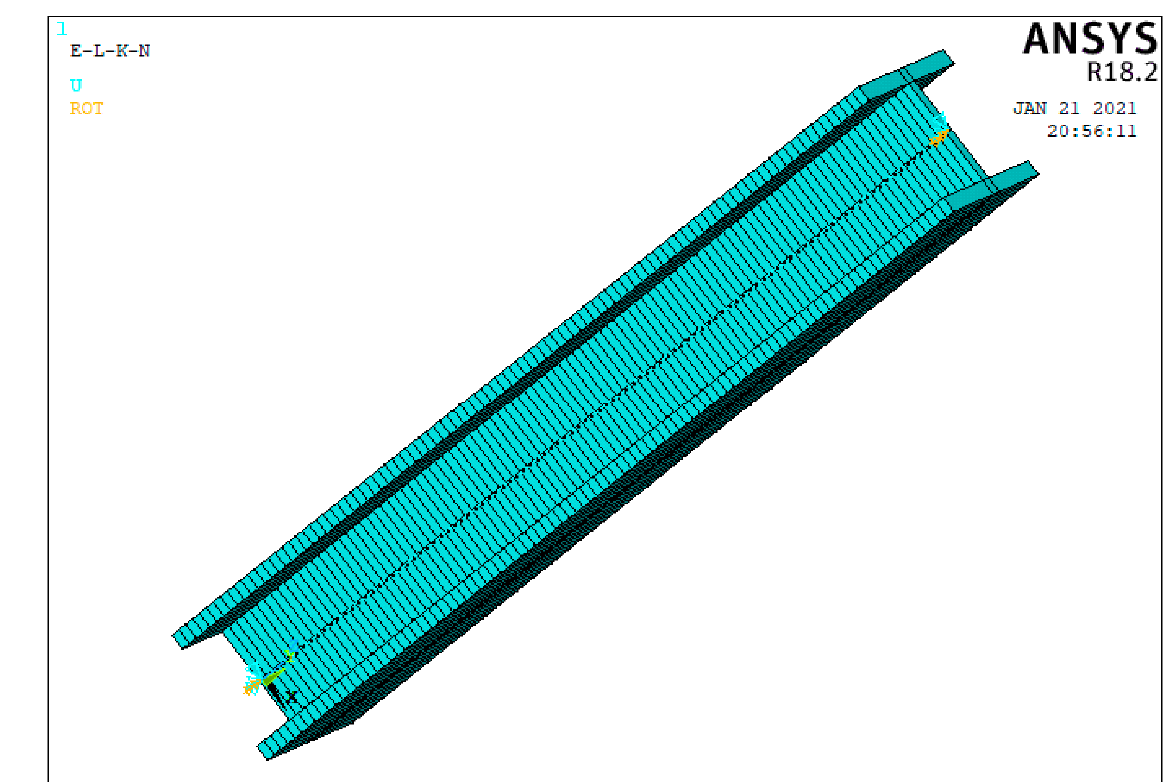
Figure 10. Grid division and constraint diagram of the H-section.